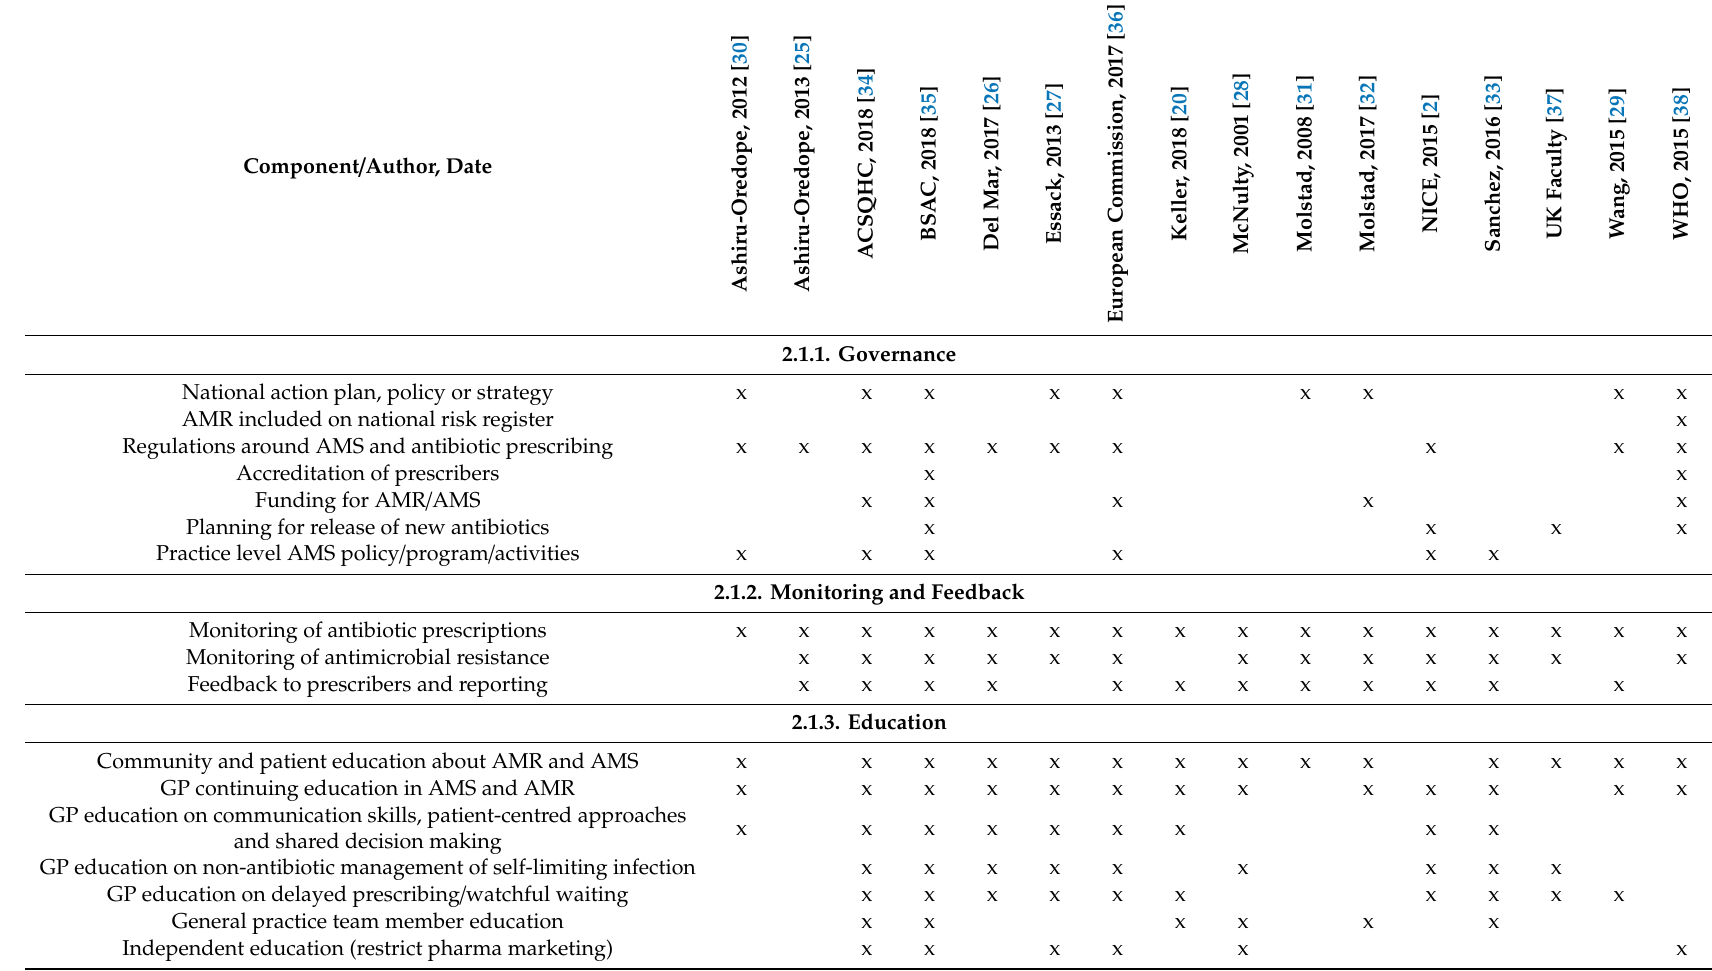
Table 1. AMS in general practice: Chart of identified component